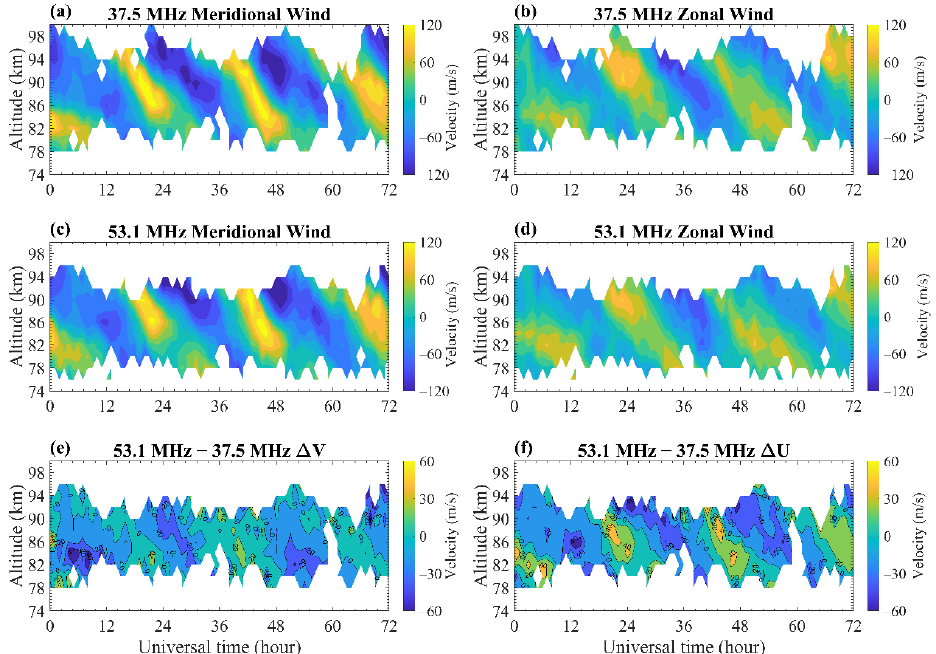
Figure 2. Comparisons between the hourly zonal and meridional winds from 8 to 10 November 2013, observed by the ( a , b ) 37.5 MHz MR and ( c , d ) 53.1 MHz MR. ( e , f ) Wind difference between the 53.1 MHz and 37.5 MHz MRs.